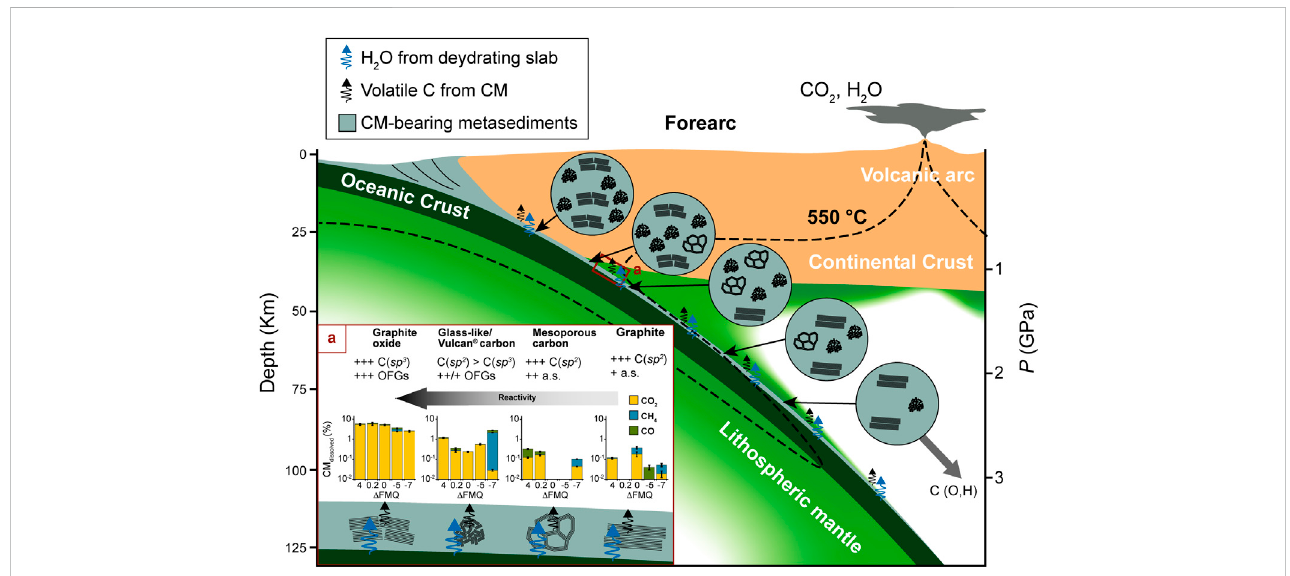
FIGURE 8 Cartoon depicting the fate of CM during subduction. CM rich in sp 3 -hybridized carbon and oxygen heteroatoms (such as GO-, GC- and VC-like CM), present as oxygenated functional groups, is likely to react at the shallowest levels and its proportion progressively diminishes with depth. MC-like CM appear as result of low grades ofmetamorphism and slowlyreactsand structurally reorganizes as long as P-T increases. Graphite-likeCMforms athigh gradesand is stable deep in the subduction zone together with some non-graphitizing GC/VC-like CM. A descending fl ux of solid carbon containing adsorbed O and H may exist. The inset (A) summarizes the results of our experimental research by reporting either the most relevant characteristics of the carbon forms and theproportionofCM dissolved ,forwhichthecontribution ofthevarious volatilecarbonspeciesisexpressed.Sinceglass-like andVulcan ® carbonhave asimilar reactivity, their bar chart is constructed by using a combination of the experimental results, selecting only those showing the highest solubility. Symbols